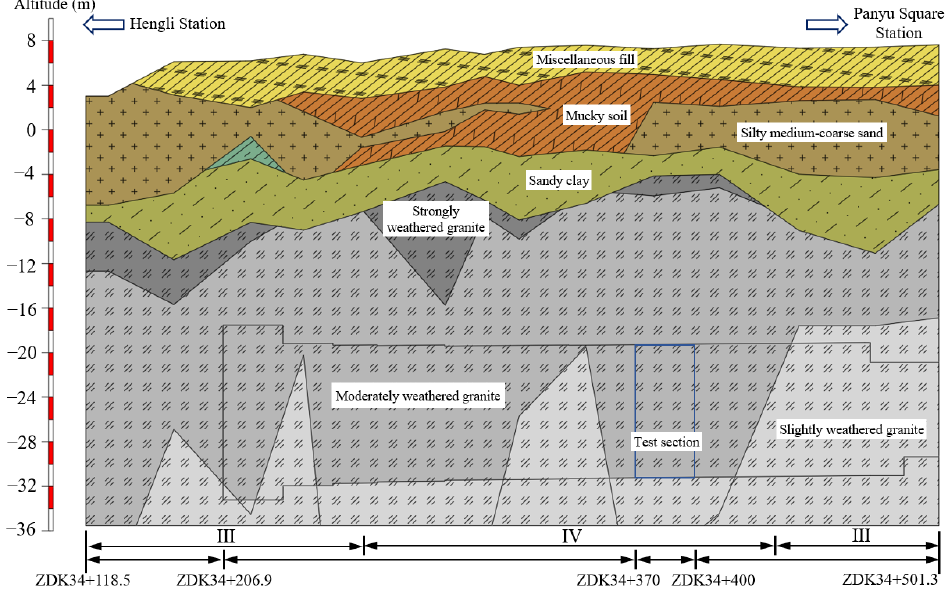
Figure 2. Longitudinal profile of geological layer of site project.